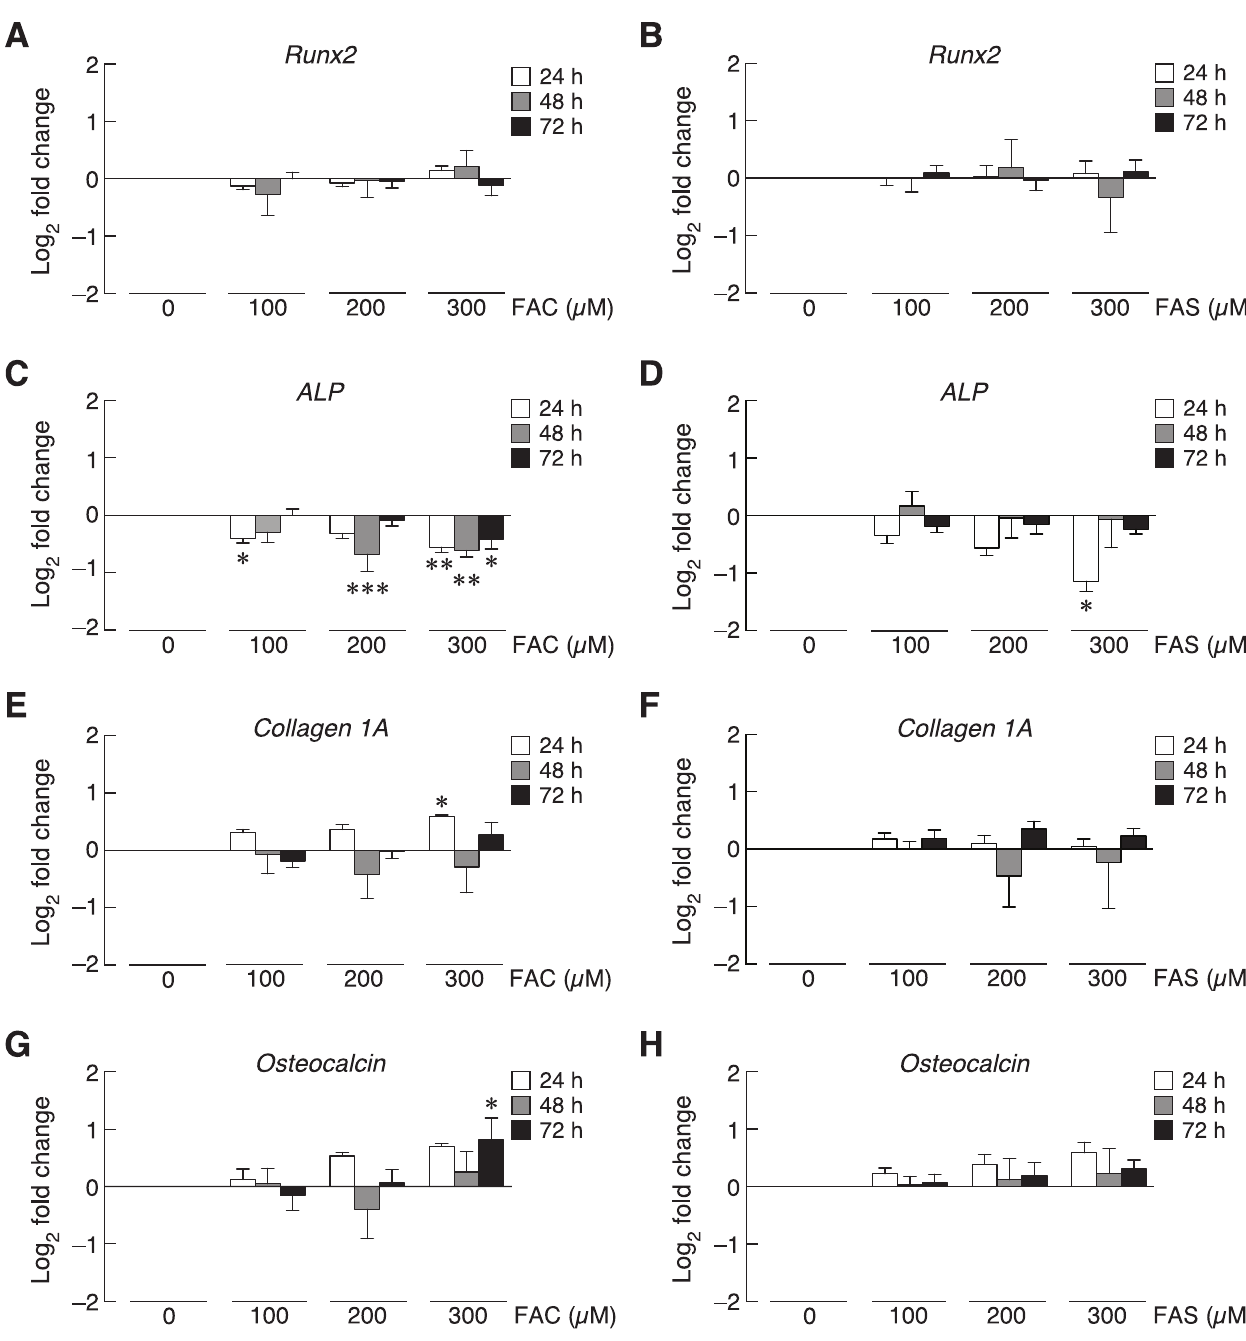
PLOS ONE | https://doi.org/10.1371/journal.pone.0234009 May 29, 2020 7 /